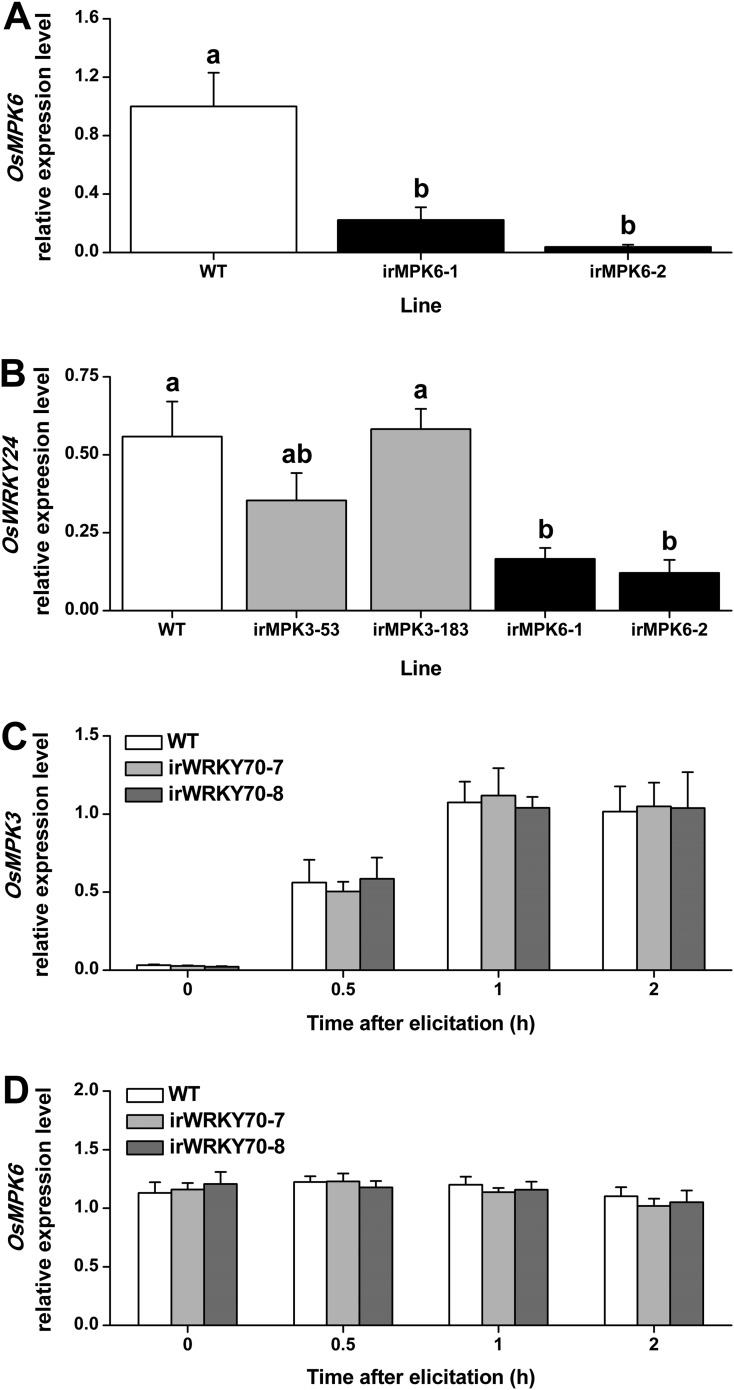
Transcript levels of OsMPK6, OsWRKY24, OsMPK3, and OsMPK6 in different transgenic lines.(A) Mean expression levels (+SE, n = 6) of OsMPK6 in OsMPK6 silenced lines (irMPK6-1 and irMPK6-2). Samples used for QRT-PCR were from plant stems that were infested by SSB for 1 hr. (B) Mean transcript levels (+SE, n = 5) of OsWRKY24 in irMPK3 (irMPK3-53, irMPK3-183) and irMPK6 lines after infestation by SSB for 1 hr. (C, D) Mean transcript levels (+SE, n = 5) of OsMPK3 (C) and OsMPK6 (D) in irWRKY70 lines after infestation by SSB for 1 hr. Letters indicate significant differences among different lines (p < 0.05, Duncan's multiple range test).